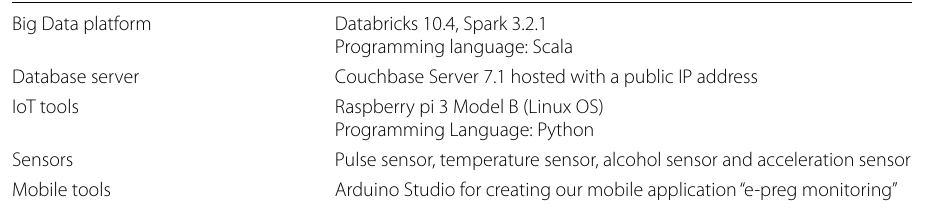
Table 3 Experiment environment Big Data